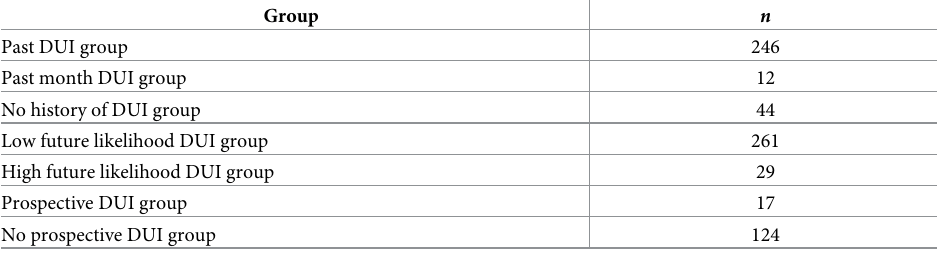
Table 3. Number of participants per DUI group Study 1.